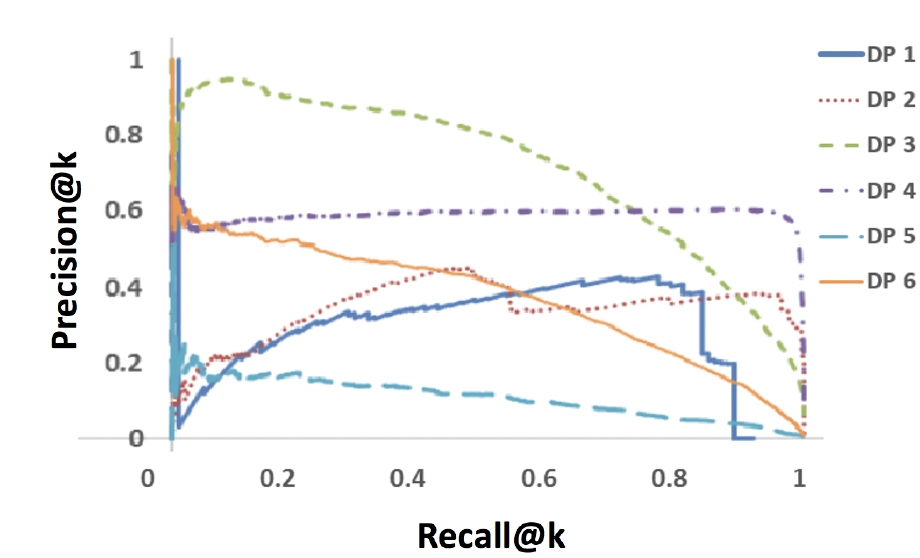
Figure 8. Dumas duplicates-generation results, for k ∈ { 1,2 . . . 50,000}.